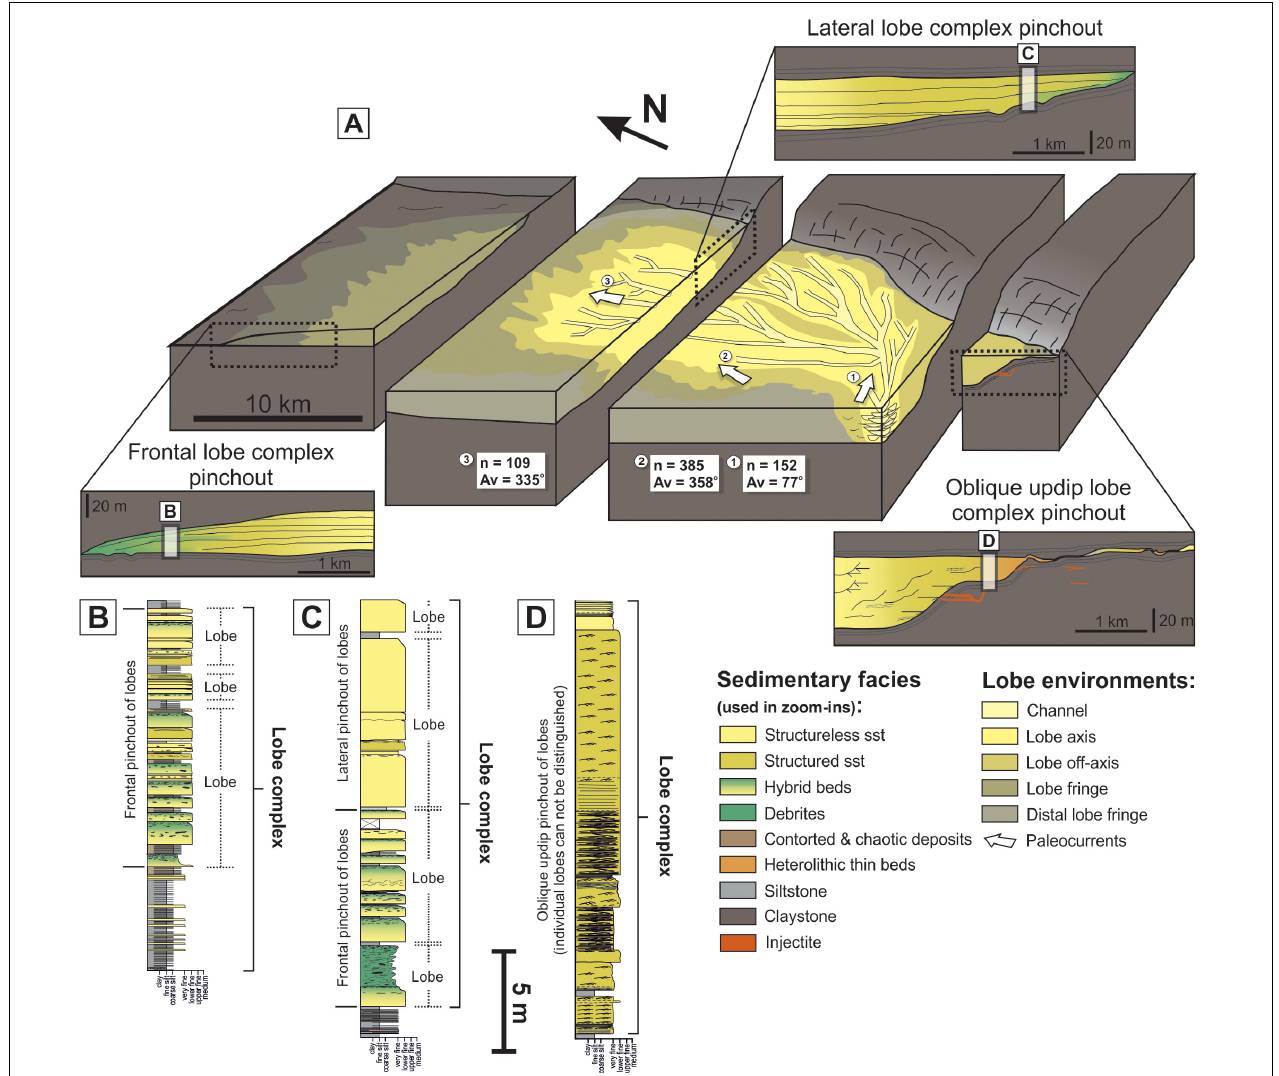
FIGURE 12 | (A) Block diagram of the Fan 3 lobe complex indicating the different lobe environments and decrease in topography on the eastern margin toward the north. The oblique up-dip, lateral and frontal pinchouts of Fan 3 are shown in detail and are color coded by sedimentary facies. (B) Example sedimentary log through the frontal pinchout of the Fan 3 lobe complex where frontal pinchouts of individual lobes can be distinguished (adapted from Spychala et al., 2017b). (C) Example sedimentary log showing a vertical section through the lateral pinchout of the Fan 3 lobe complex where frontal and lateral lobe pinchouts occur in a 1D section. (D) Example sedimentary log showing a vertical section through the oblique up-dip pinchout of the Fan 3 lobe complex. Note that the individual lobes cannot be